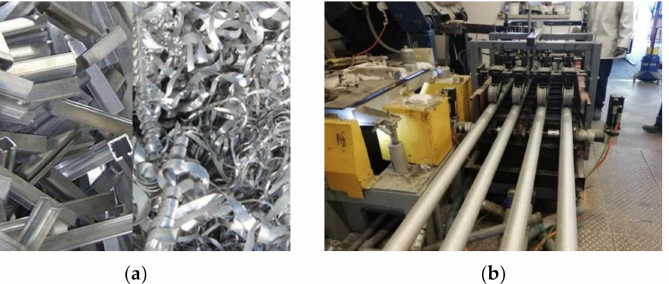
Figure 1. Scrap constituting the input for melting and obtaining a technical 2017A alloy ( a ) and a station for continuous casting of ingots ( b